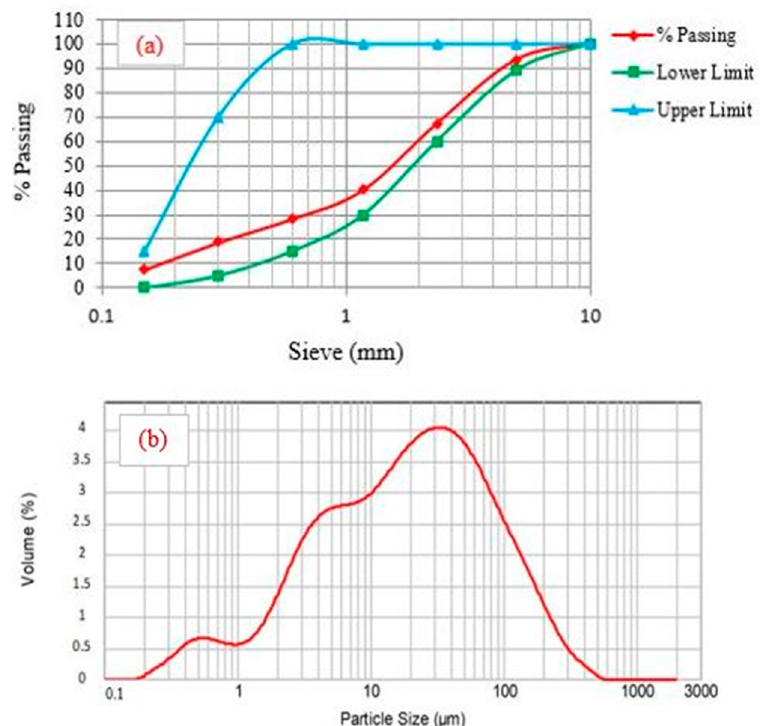
Figure 1. The particle size distribution of; ( a ) sand, ( b ) fly ash (FA). Table 2. Mix proportion and strength of OPC.